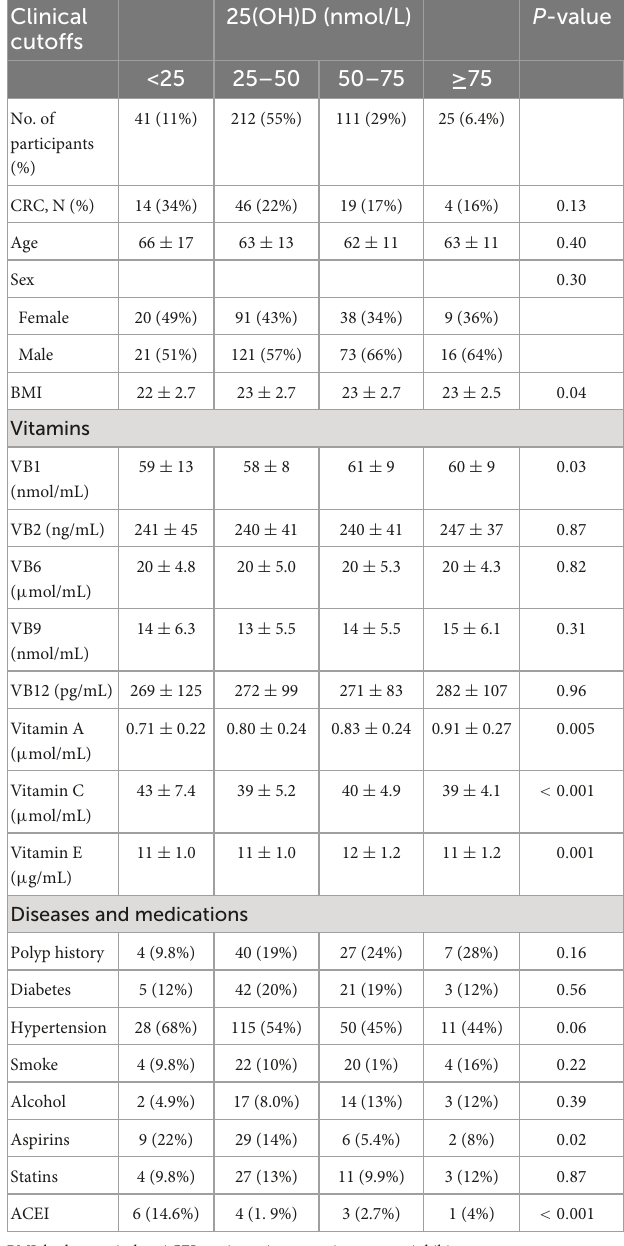
TABLE 1 Characteristics of the study participants according to clinical cutoff concentrations of serum